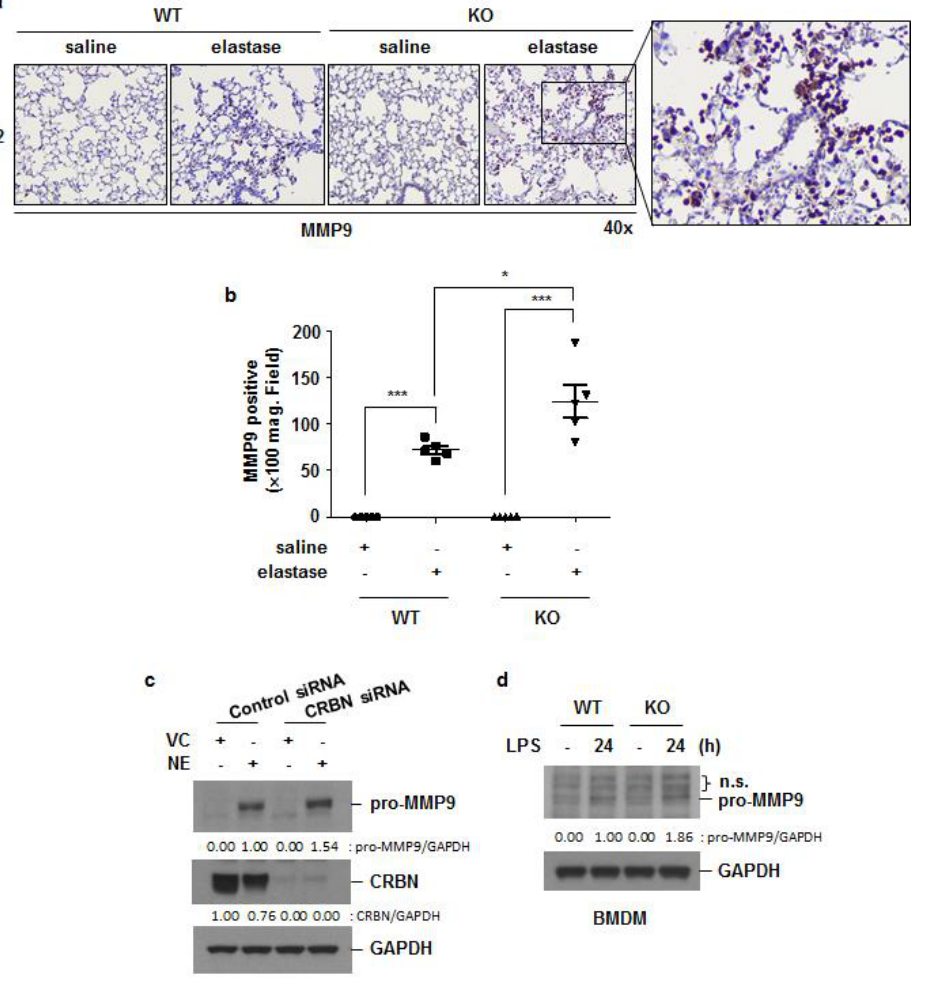
Figure 7. Crbn KO increased elastase-induced MMP9 expression. WT and Crbn KO mice were given 0.5 units of elastase via intratracheal injection. (Day 2: WT-saline n = 5, WT-elastase n = 5, KO-saline n = 5, KO-elastase n = 5). ( a ) Representative images of MMP9 immunohistochemical staining in lungs from WT and Crbn KO mice on day 2 (d2) after intratracheal instillation of elastase (×40). ( b ) Quan- tity of MMP9 positive cells in ×100 field of the whole group. Data represent the mean ± SE. * p < 0.05, and *** p < 0.001. ( c ) BEAS-2B cells were transiently transfected with control siRNA or Crbn siRNA.